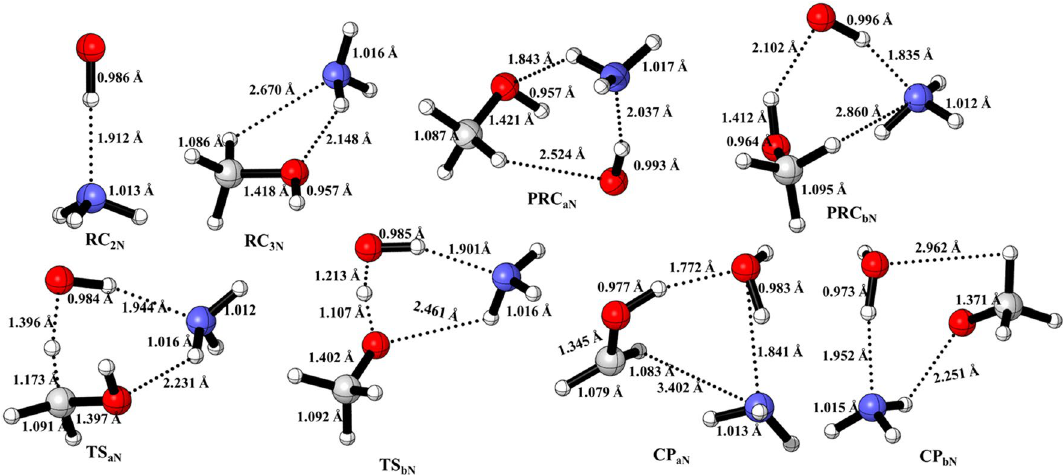
Figure 4. Optimized structures of ammonia-assisted pre-reactive complexes, transition states and post-reactive complexes were obtained using